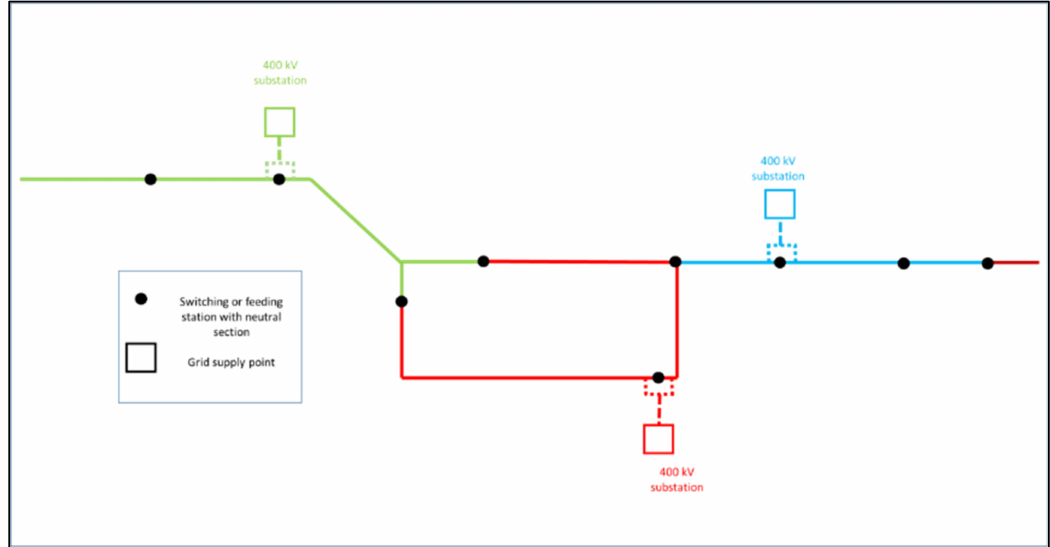
Figure 2. Typical major feeding diagram of a 25 kV electrification scheme (based on a simplification of the Great Western Electrification Project in UK [6,7]).